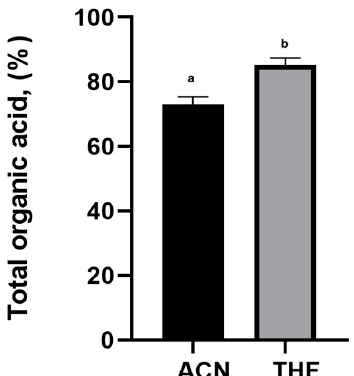
Figure 1. The effect of extraction solvents on the yield of organic acid derivatives (expressed in percentage of the total amount of lactic, malic, and glycolic acids) from Saffron stigmas extract, n = 6. Values within columns followed by the same lowercase letter (a, b) di ff ered statistically at p < 0.05 (Tukey’s test). Results are expressed as means ± standard